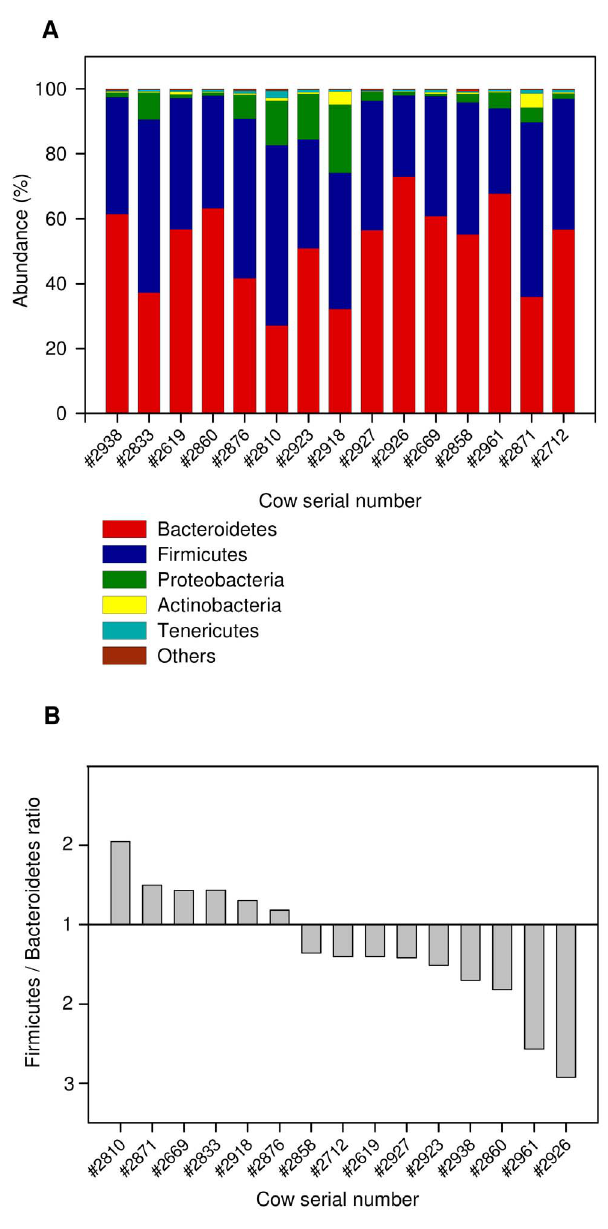
Figure 1. Phylum level composition. (A) Stacked bar plot showing the phylum-level composition for each individual cow rumen sampled. (B) Ratio of Firmicutes to Bacteroidetes.